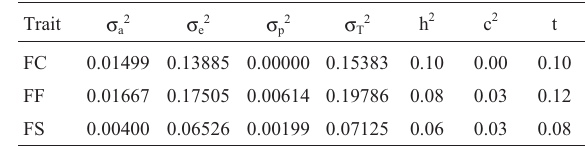
Table3 -Leastsquaremeans( ± standarderror)ofnumberoffliescounted on animals (FC), number of flies in photographs (FF), and of infestation score (FS), according to season.